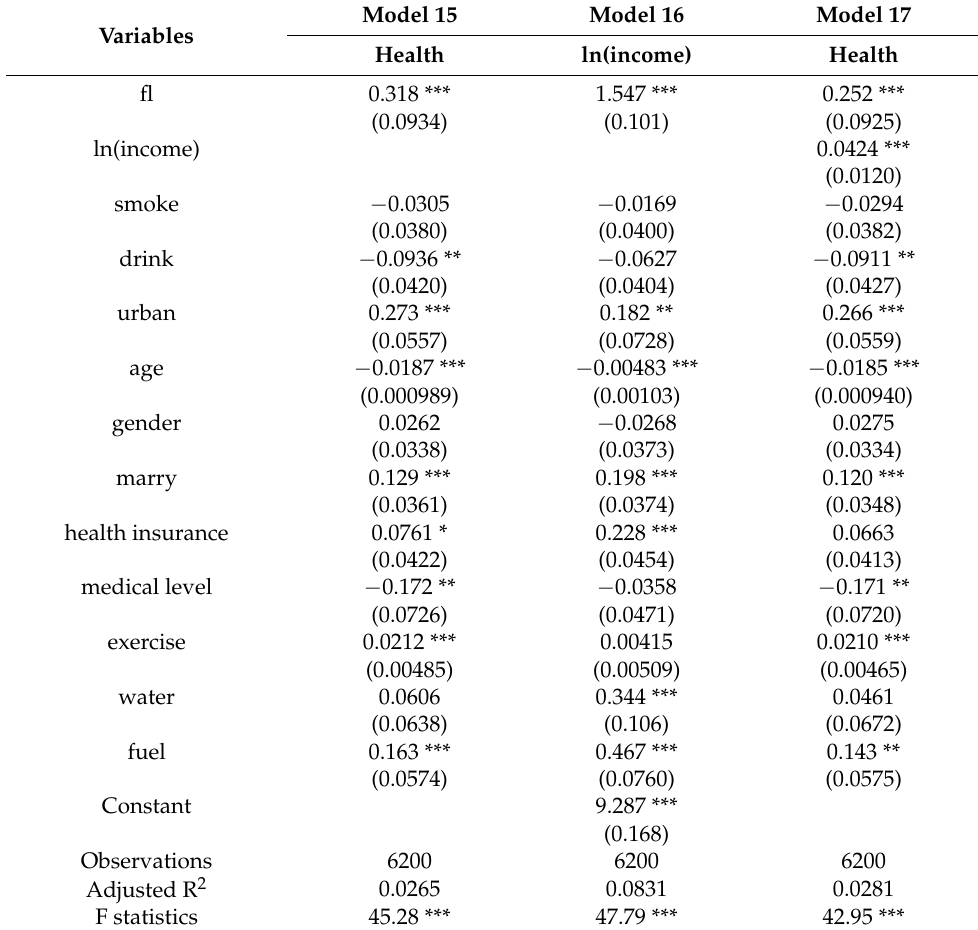
Table 8. The mediating effect of financial literacy on the residents’ health: